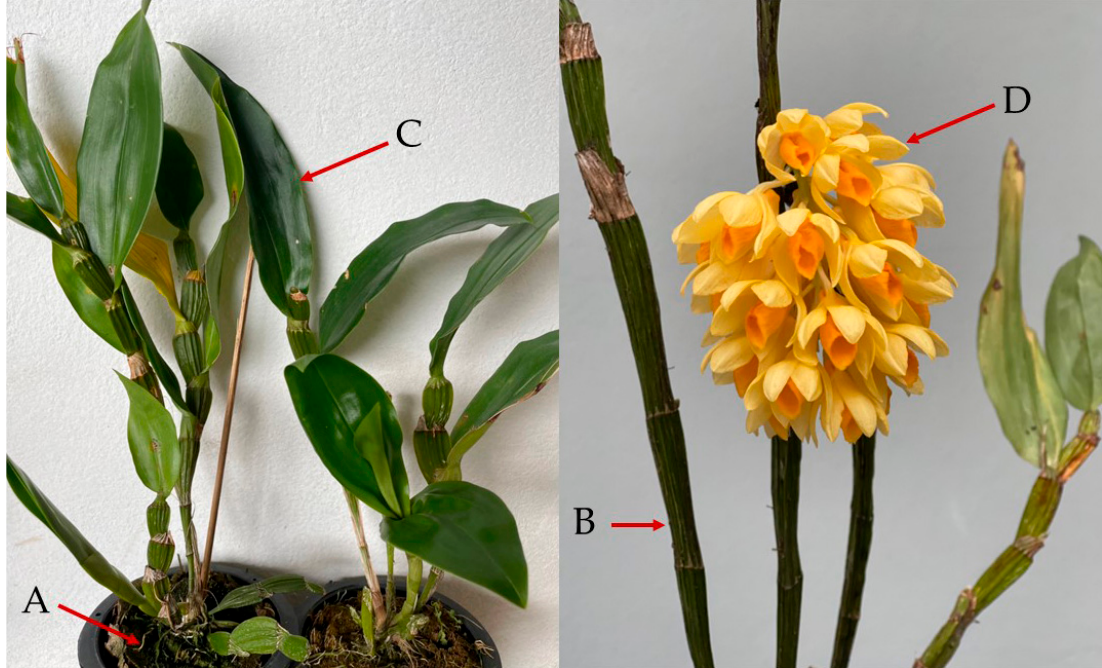
Figure 1. The different parts of D . sulcatum : (A) root, (B) stem, (C) leaf and (D) flower.